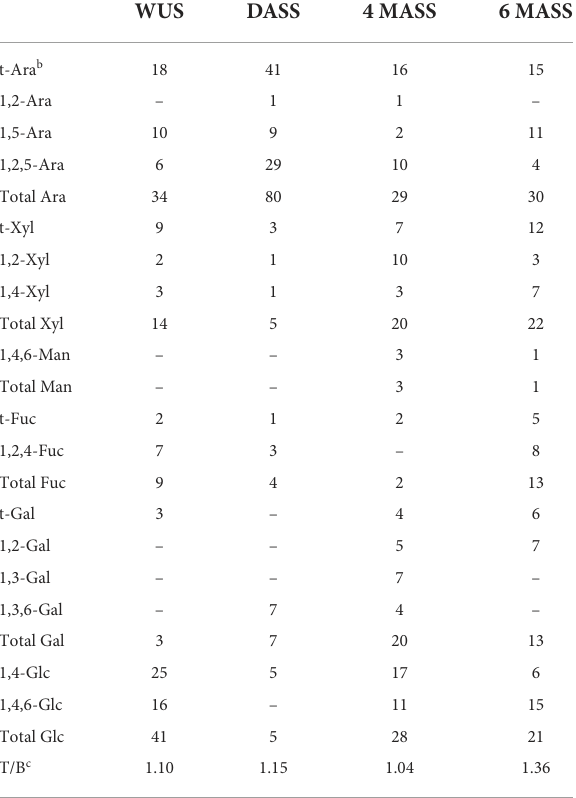
a Adaptedfromreference(14). b t,terminal. c T/B,ratioterminallylinkedresidues:branchingpoints. Ara, arabinose; Xyl, xylose; Man, mannose; Fuc, fucose; Gal, galactose; Glc, glucose; UA, uronicacid.